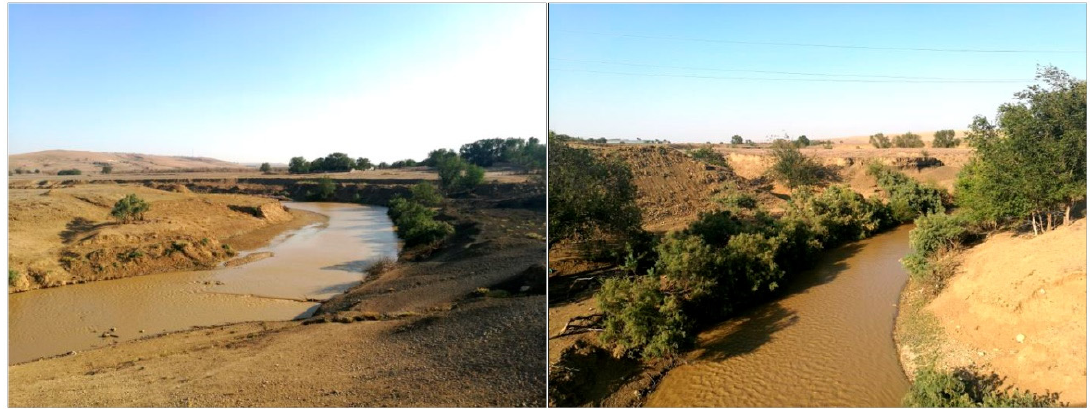
Figure 2. The Kalaus River at the village of Sergiyevka (the photos by A.V. Gusarov, September 2020). The Kalaus River has 81 tributaries with a total length of 936 km. The main sources